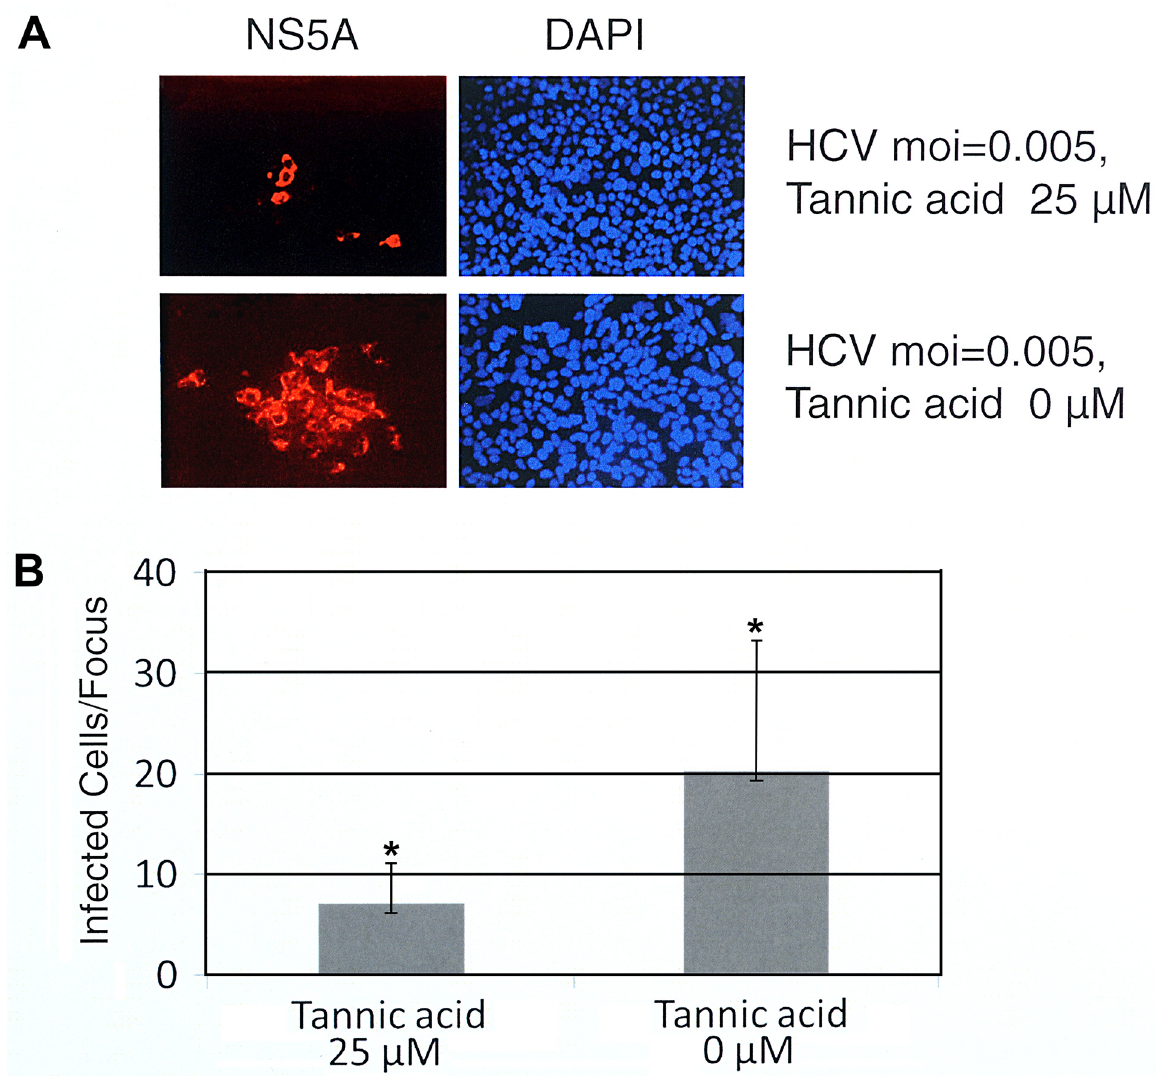
Fig 6. Effect of tannic acid on cell-to-cell spread of HCV. (A) The effect of tannic acid on cell-to-cell spread of HCV as measured by viral protein staining. Huh7.5 cells were infected with HCV using an MOI of 0.005 at 37°C. The inoculum was removed two hours post infection and replaced with a 1% agarose medium overlay containing 25 μ M tannic acid. Controls had no tannic acid. Cells were incubated at 37°C for 72 hours as described in Materials and Methods. Infected cells were labeled by indirect immuno-fluorescence using an anti-HCV NS5A monoclonal antibody (red), nuclei were stained with DAPI (blue) and photographs were taken with a fluorescence microscope as described in Materials and Methods. (B) The mean and standard deviation of infected cells/focus was determined by visual counting of 30 foci present on randomly selected fields of cover slips for each condition. P-values were calculated using the Student ’ s ttest (asterisk indicates P = 0.000019). Experiments were performed three times and representative examples are shown in A and